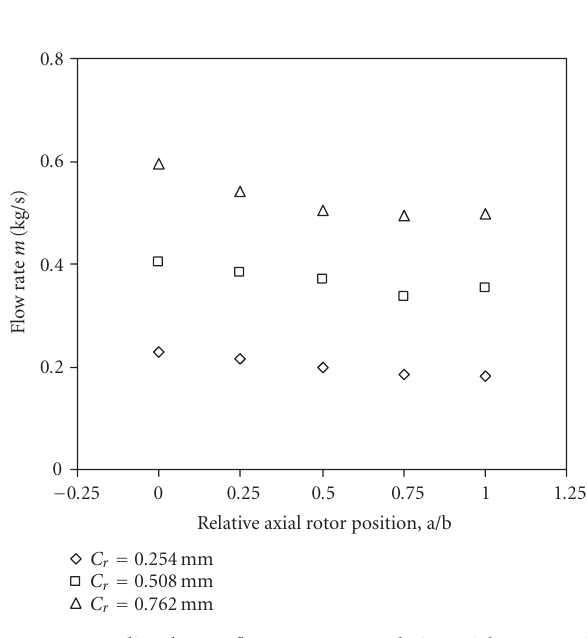
Figure 4: Predicted mass flow rate versus relative axial rotor posi- tion a/b for high-low seals.